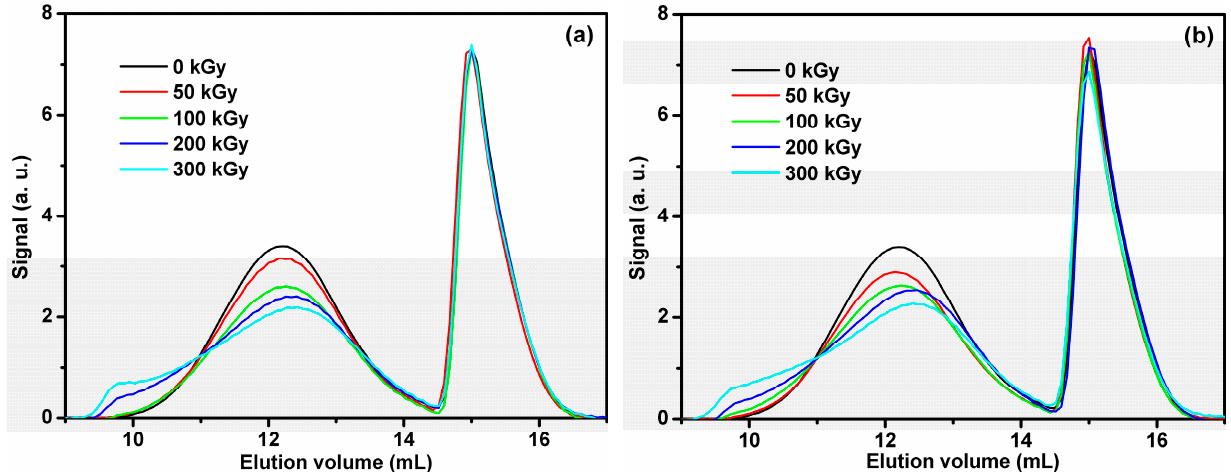
Figure 4. GPC curves of the Estane samples irradiated in air ( a ) and water ( b ).